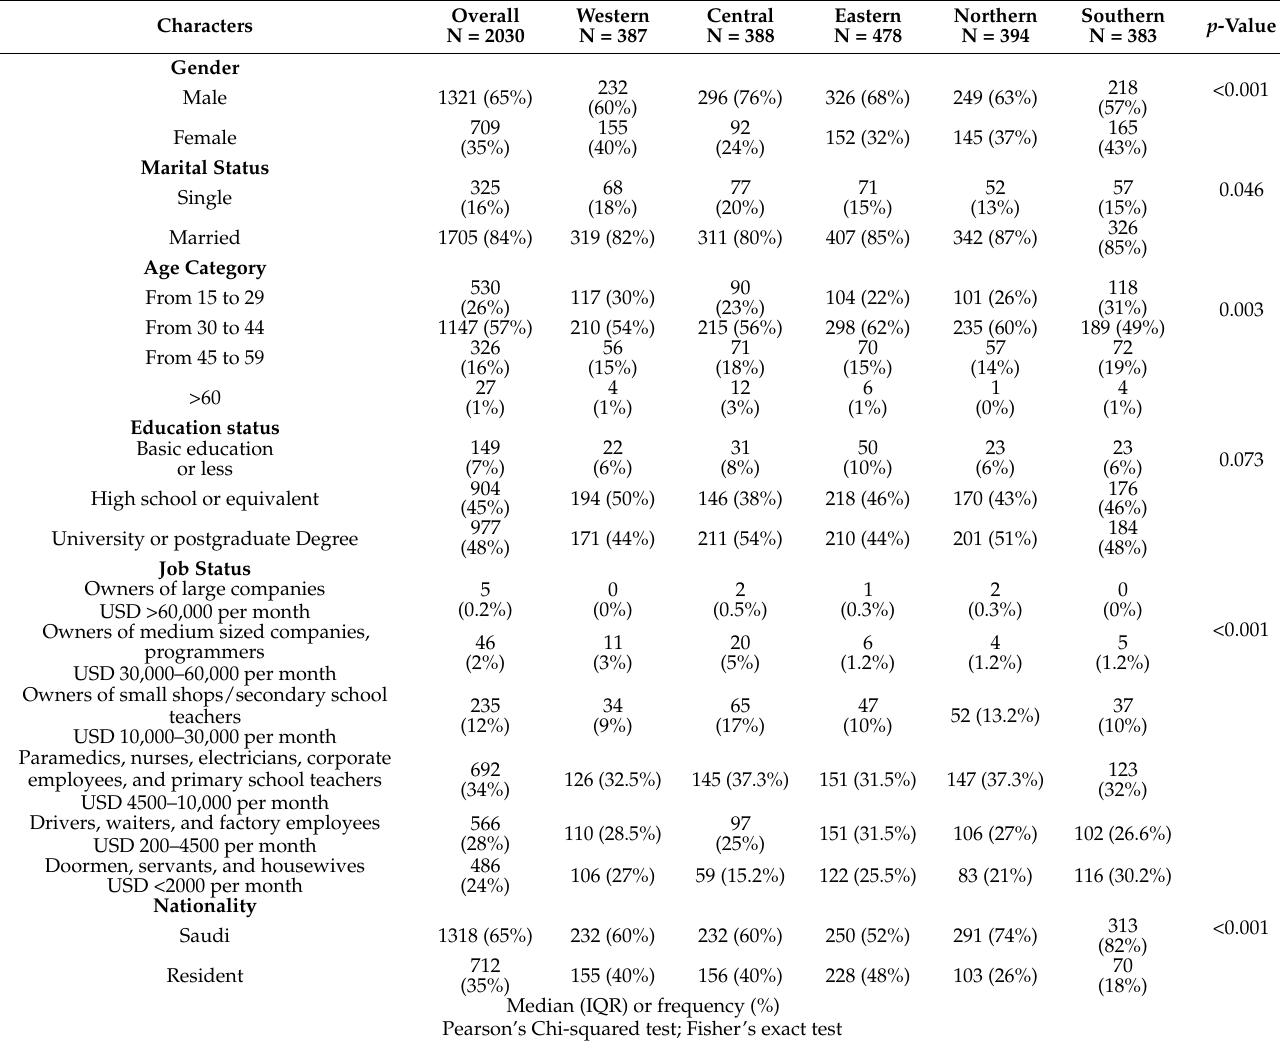
Table 1. Demographic characteristics of the study participants distributed across different